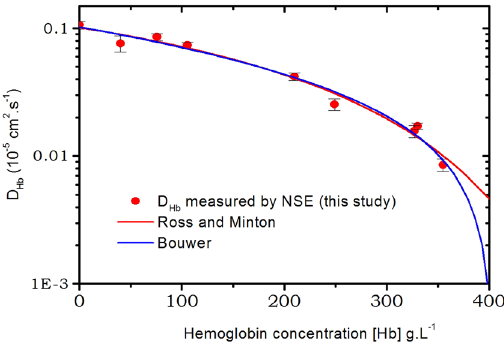
Figure 5. Self-diffusion coefficient D s ( c p ) measured by NSE spectroscopy (red circles) and refinements using the modified Mooney formula given by Ross and Minton 41 (red line) and empirical formula used by Bouwer et al . 22 (blue line) (see